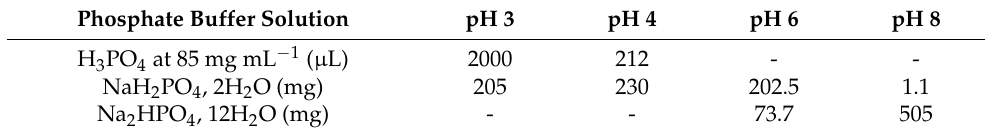
Table 4. Phosphate buffer solution composition in 50 mL at various